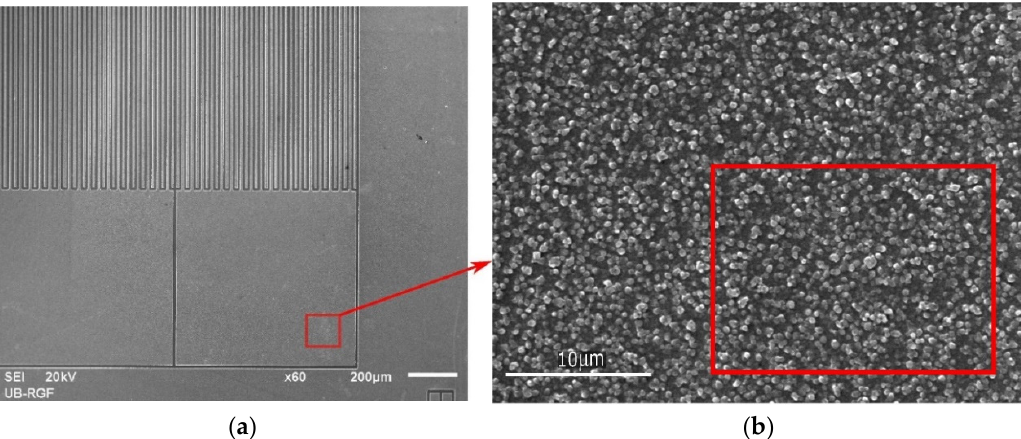
Table 1. Atomic composition of the sensor surface.